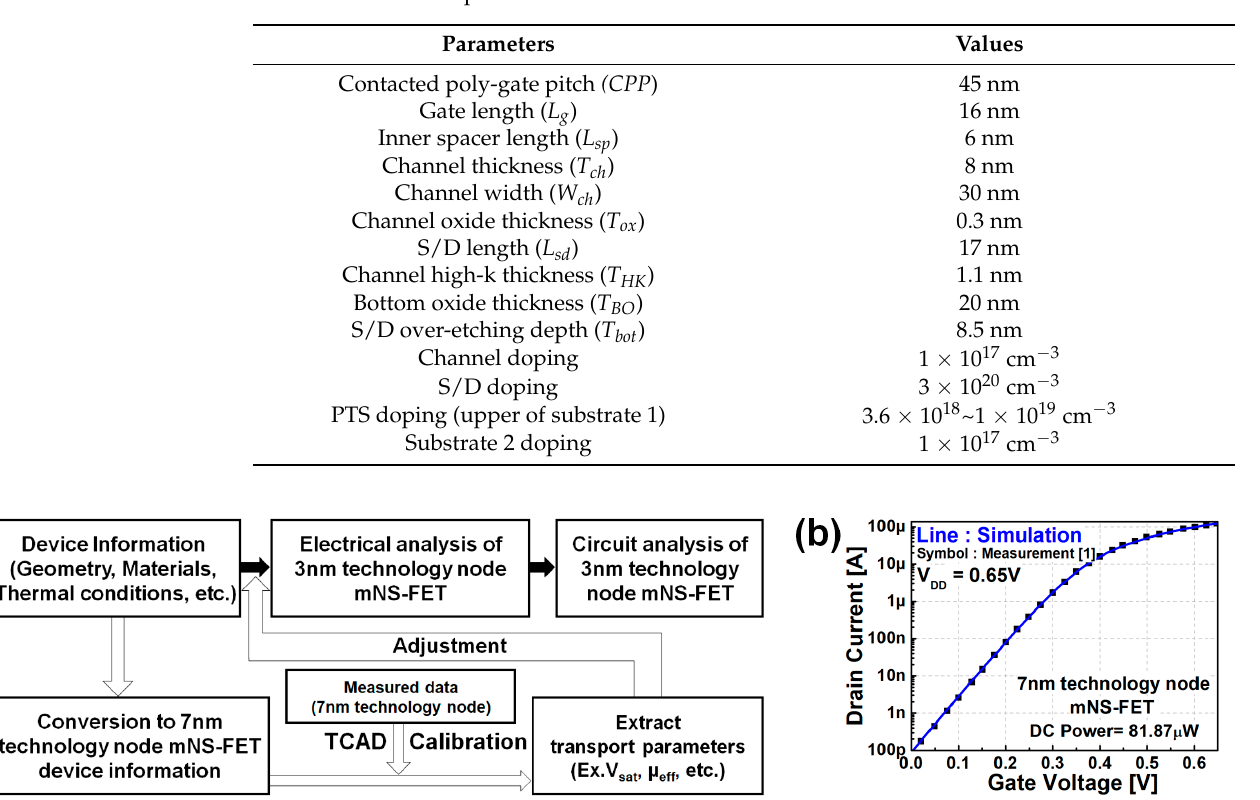
Figure 1. ( a ) 3D structure and cross section view of mNS-FET with PTS doping scheme, ( b ) 3D structure and cross section view of mNS-FET with bottom isolation scheme. Table 1. Geometrical parameters for multi-nanosheet channel FET.